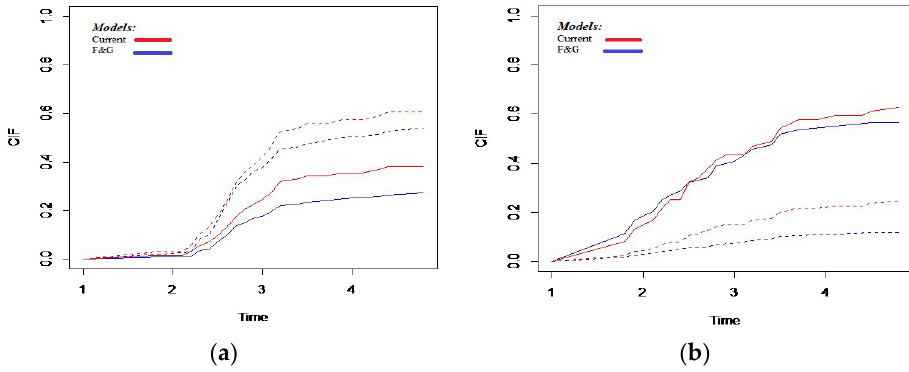
Figure 2. Comparison of the CIF’s Current Model (49% Masked Observations) with F&G Model for: ( a ) Cause 1, solid line: X = 0.5. Dashed line: X = −0.5. ( b ) Cause 2, solid line: X = 0.5. Dashed line: X = −0.5.